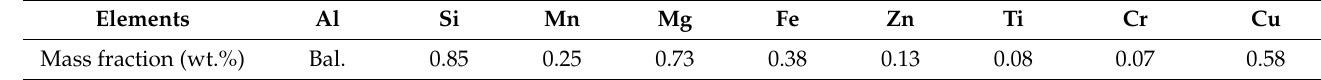
Table 4. Chemical composition of AA6111 aluminum